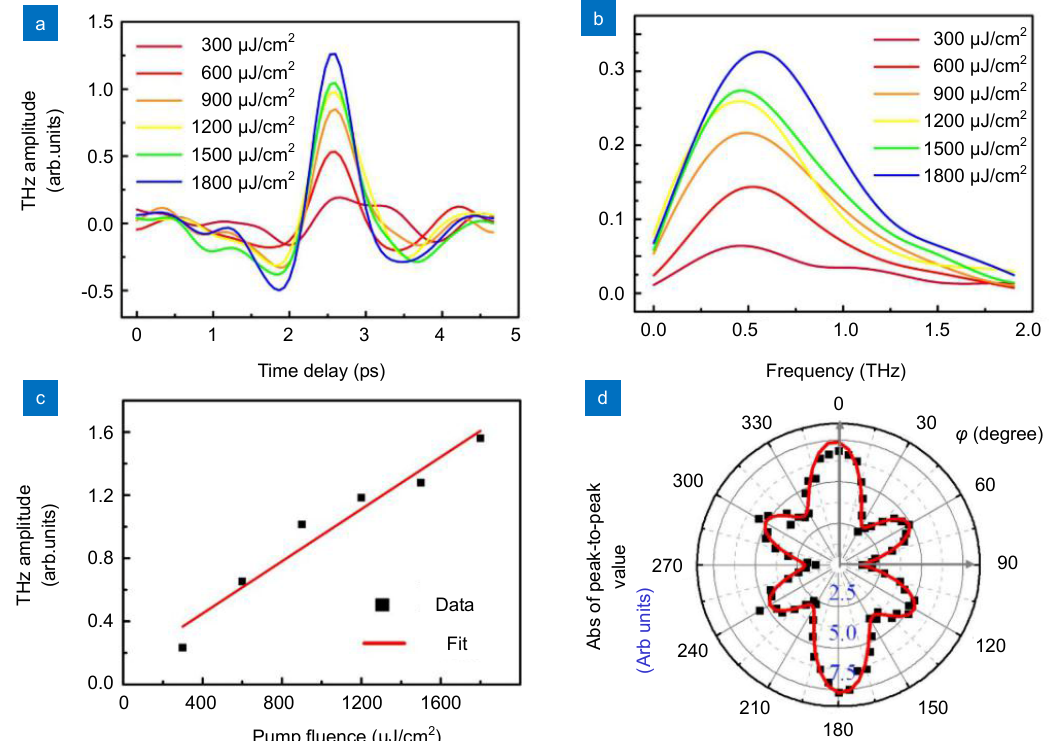
Fig. 5 | ( a ) THz waveforms at different photoexcitation power with the wavelength center in 800 nm. ( b ) Fast Fourier transformations (FFT) spectra for the directly measured terahertz waveforms that are shown in (a). ( c ) THz amplitude versus the power of the incident laser beam. ( d ) The azimuthal dependent ( φ -dependent) absolute amplitude of THz emission waveforms with linear polarized optical